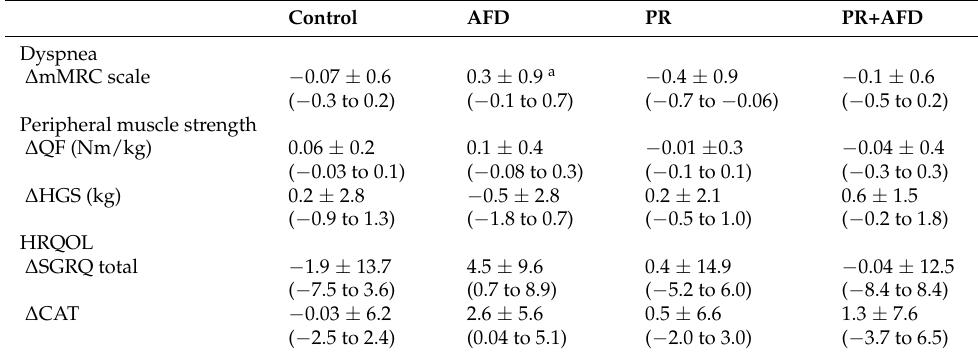
Table 3. Comparison of the change between baseline and 3 months between the groups.